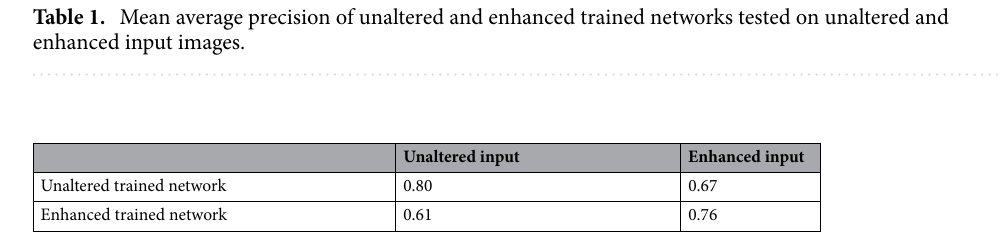
Table 2. F1 score of unaltered and enhanced trained networks tested on unaltered and enhanced input